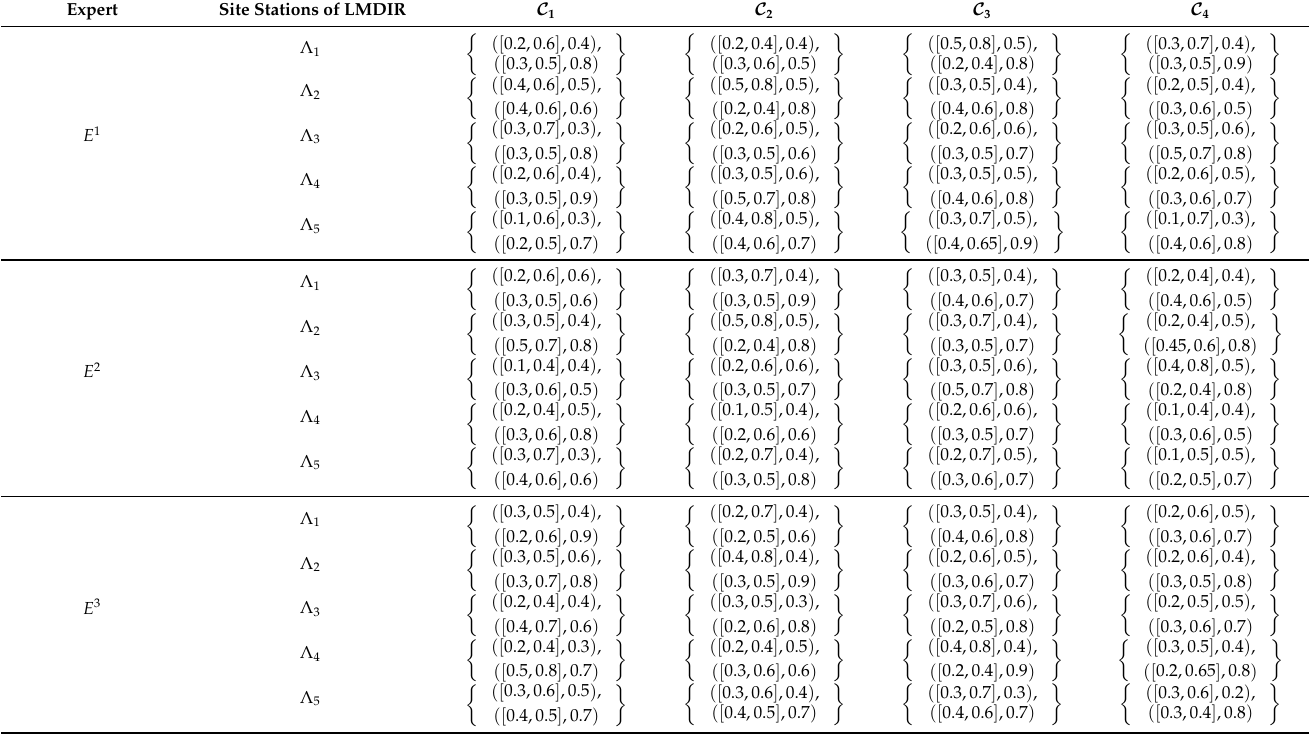
Table 1. Fermatean cubic fuzzy assessment matrices provided by